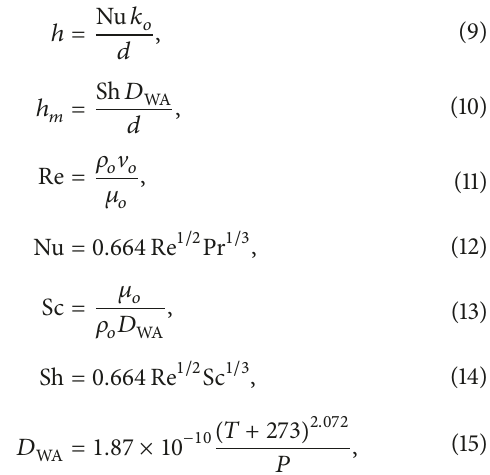
The drying rate (DR) was estimated based on the moisture ratio (dimensionless moisture) reduction as a function of time as suggested by Franco et al.